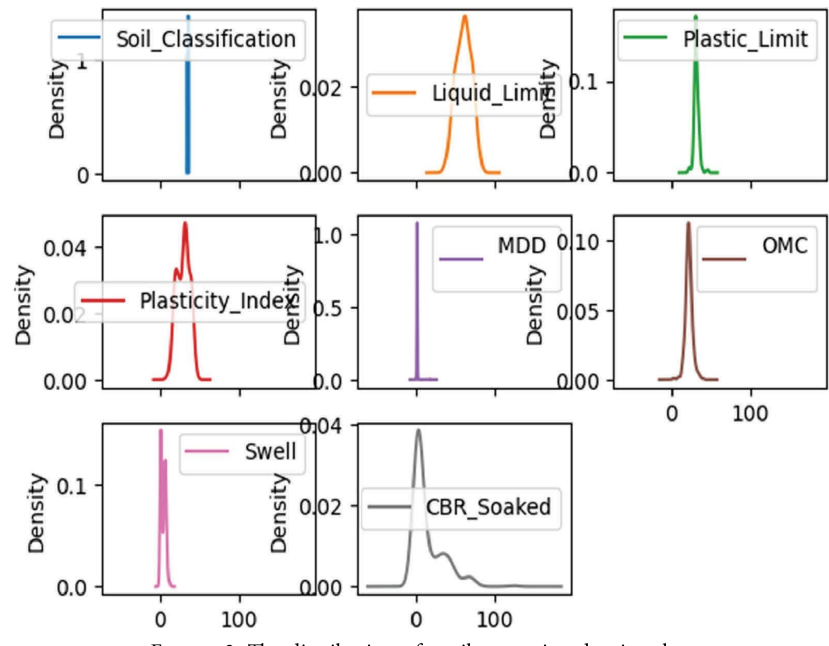
Figure 2: Te distribution of attributes using density plot.